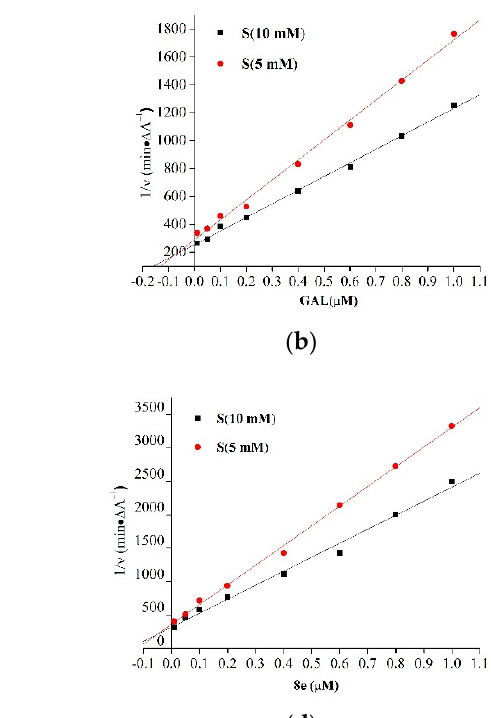
Figure 4. The Lineweaver–Burk plots showed both increasing slopes and increasing inter- cepts for higher inhibitor concentration. As listed in Table 2, compounds 8b (K i = 49.20 nM) and 8e (K i = 50.81 nM) were the most potent AChE inhibitors among all coumarin–BMT hybrids tested. However, their K i values were both slightly higher than the K i value of THA (K i = 31.13 nM), and lower than the K i value of GAL (K i = 61.93 nM). Their pattern indicated a mixed-type inhibition, which was similar to that of THA and GAL.